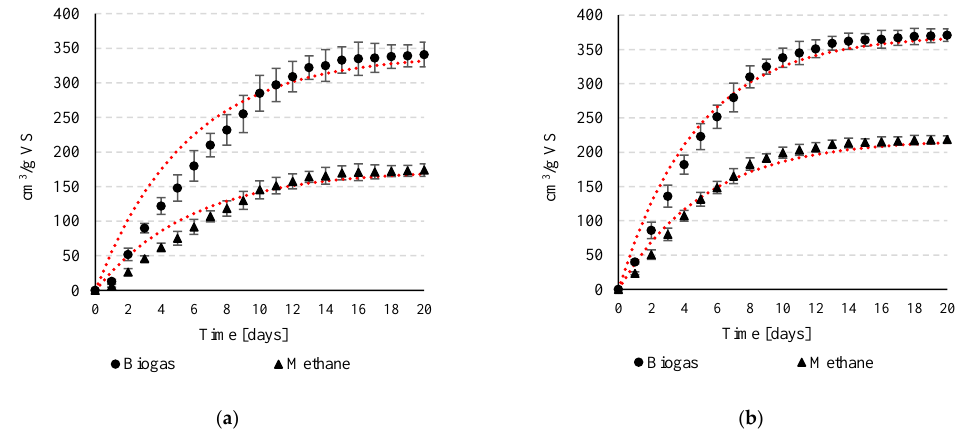
Figure 5. The course of anaerobic digestion in S1 depending on experimental variant (( a ) variant 1; ( b ) variant 2). Table 6. Indicators characterizing the course of methane fermentation of hydrophyte biomass.